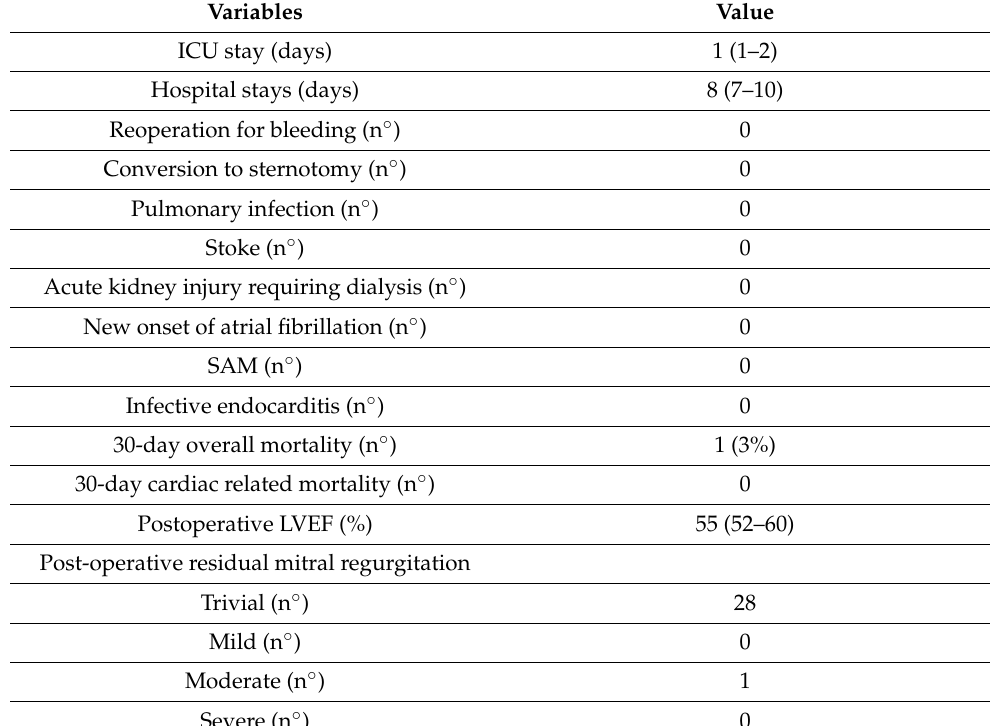
Table 4. Post-operative